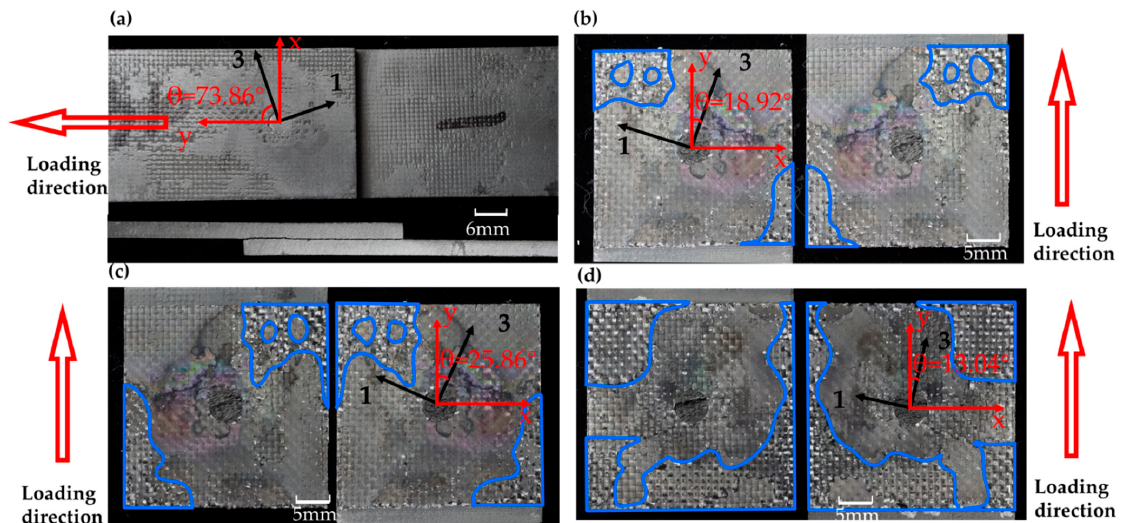
Figure 4. Failure patterns of the four specimens: ( a ) Specimen 1; ( b ) Specimen 2; ( c ) Specimen 3; ( d ) Specimen 4.